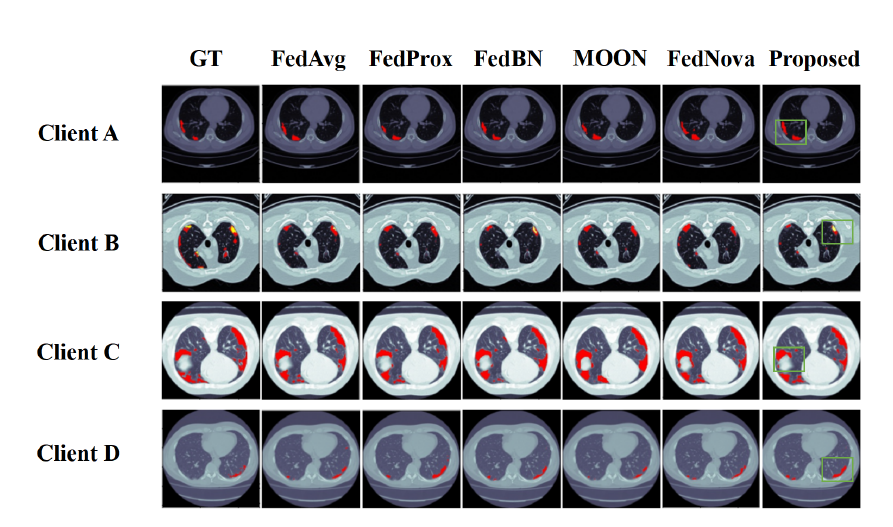
Figure 6. Visual comparison of COVID-19 infection regions segmentation results on the four clients, where the red labels denote COVID-19 infection regions, and the green boxes highlight some segmen- tation